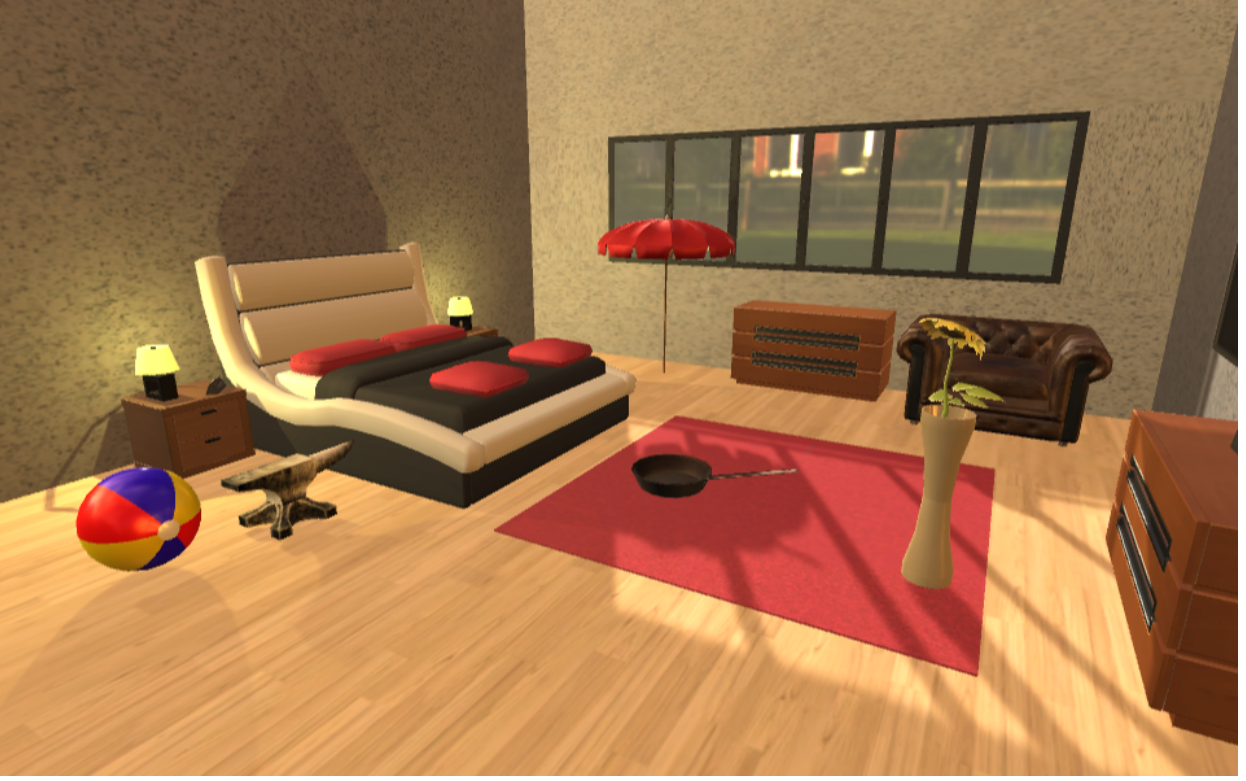
Figure 4. Demo A: sample